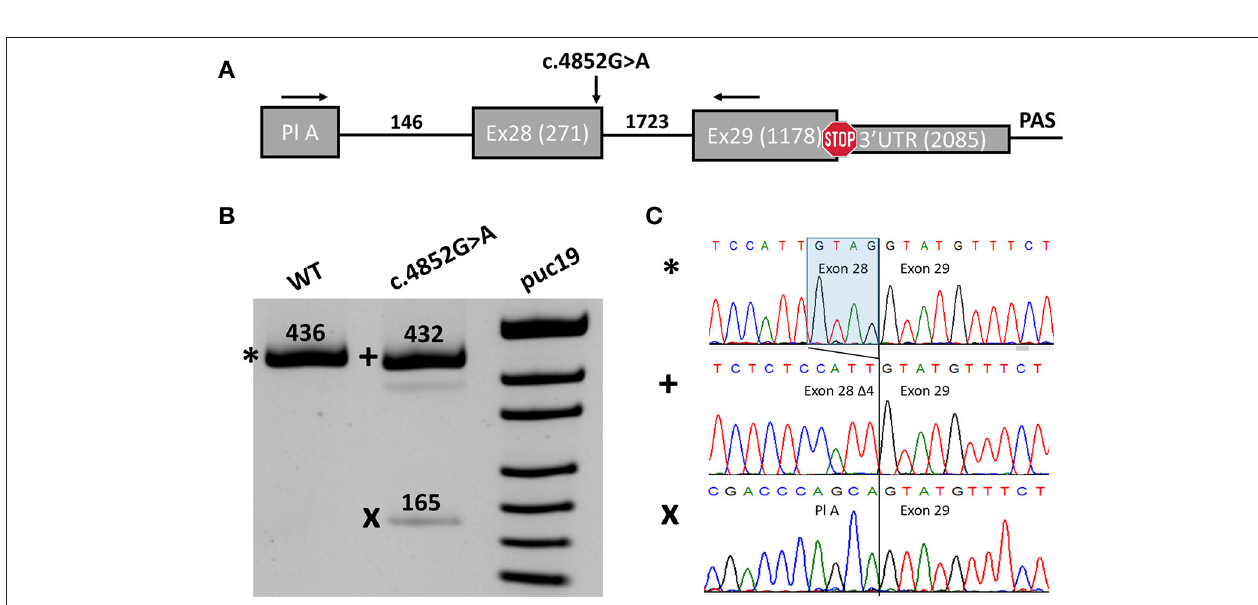
FIGURE 2 | Midigene splicing assay results. (A) Scheme of the midigene plasmid used for splicing analysis with numbers indicating the length of exons and introns. The location of primers used for RT-PCR and the investigated variant are shown with black arrows. Pl A, plasmid exon A. (B) PAGE urea electrophoresis of RT-PCR products. *, Wild type isoform; + , isoform with four-nucleotide deletions of exon 28; x, isoform with exon 28 skipping. WT, wild type. (C) Sanger sequencing of the corresponding isoforms.